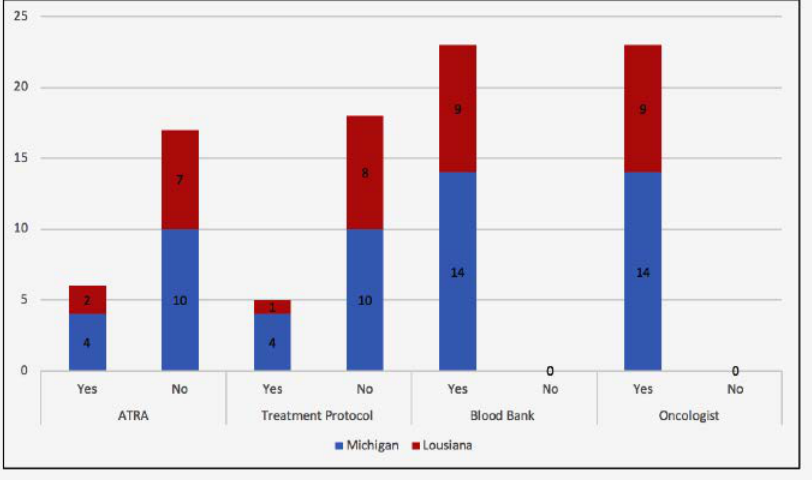
Figure 1. The availability of all-trans retinoic acid (ATRA), a treatment protocol, blood bank, and staff hematologist/oncologist among 23 acute promyelocytic leukemia treat- ment facilities in Michigan and Louisiana